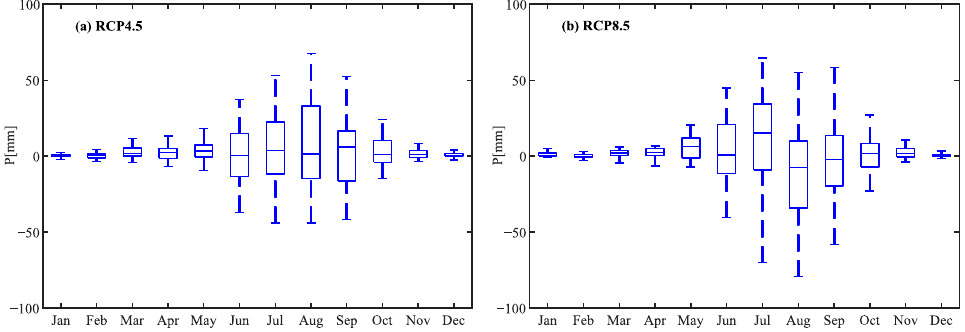
Figure 7. Variation of monthly precipitation with irrigation under the RCP4.5 ( a ) and RCP8.5 ( b